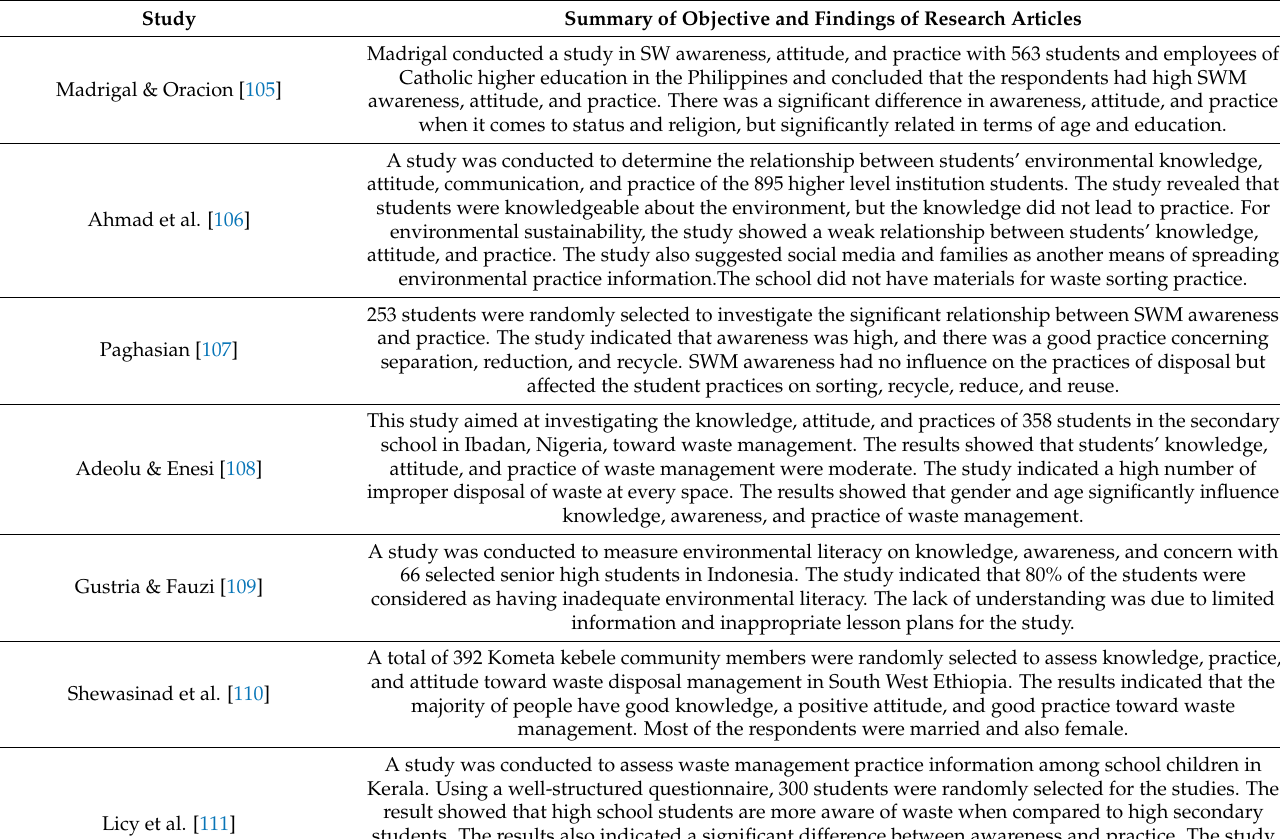
Table 2. Synthesis of the analysed study’s objectives and main